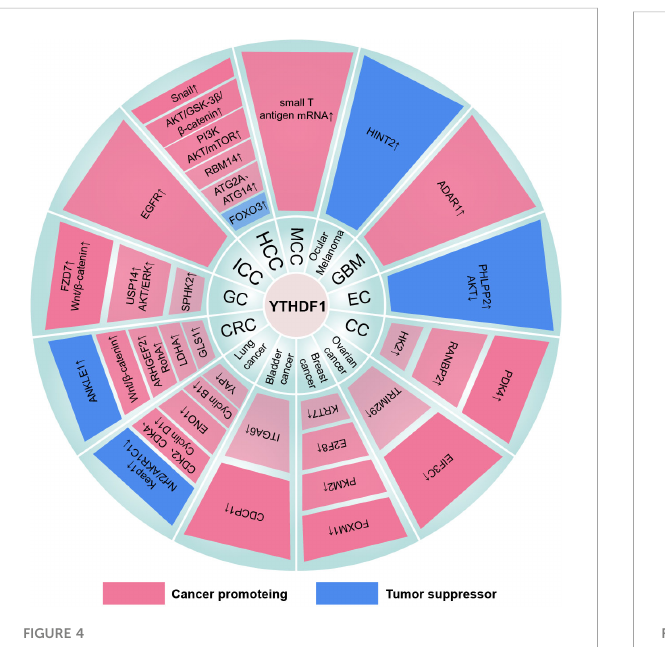
FIGURE 4 The mechanism of the YTHDF1 family in cancers. “ ↓ ” is the decrease of target mRNAs. “ ↑ ” is the increase of target mRNAs.